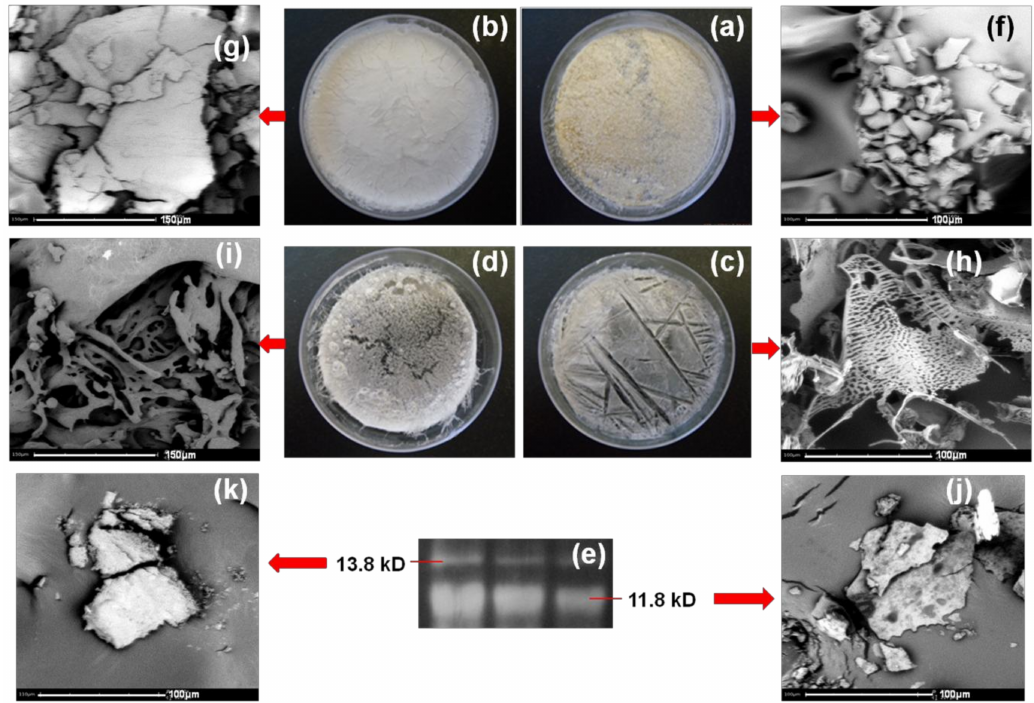
Figure 6. Morphology of α -gliadin ( a , f ); α -gliadin dissolved in urea ( b , g ); α -gliadin digested at 50 ◦ C ( c , h ); α -gliadin digested at 37 ◦ C ( d , i ); and isolated self-organized peptides ( e ) with molecular weights of 11.8 ( j ) and 13.8 kD ( k ).